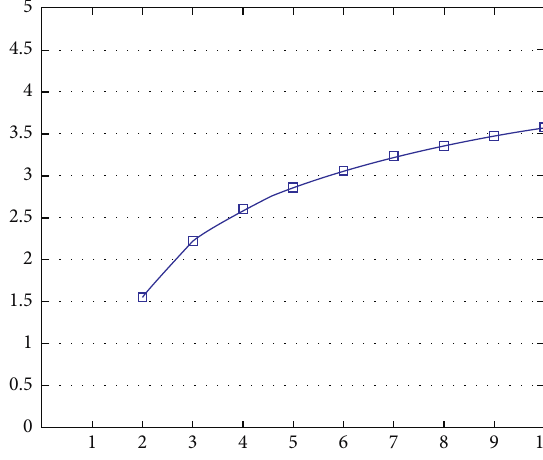
Figure 8: ABC entropy of HDN1 ( n ) .